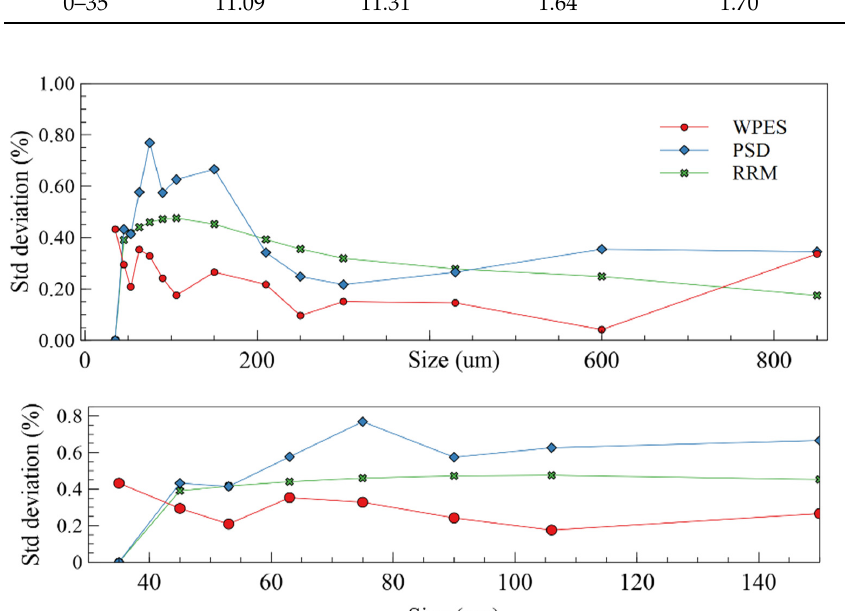
Figure A2. Standard deviation for grinding time of 12 min with 95% confidence. Top , WPES, PSD, and RRM for all range size; Bottom , those for mainly fine sizes.